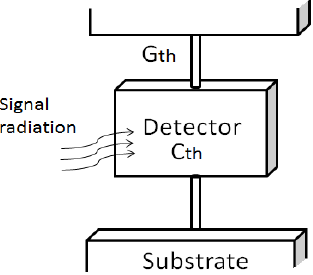
Figure 1. Concept of microbolometer thermal insulation.